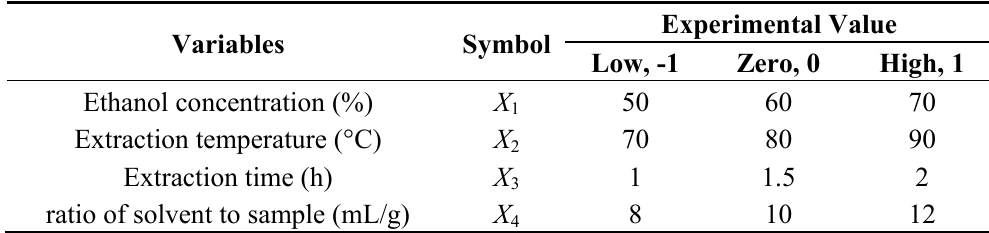
Table 4. Levels of the variables of Box-Behnken design